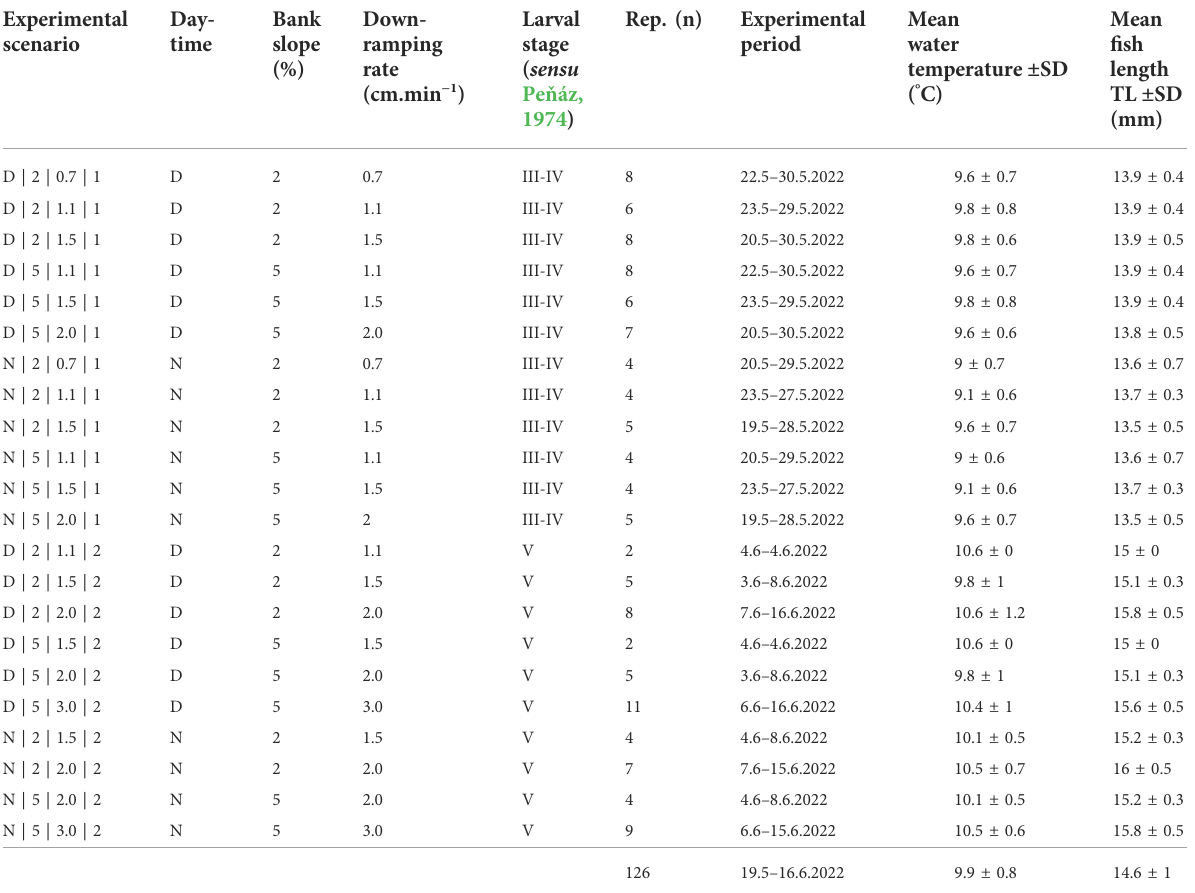
TABLE 1 Overview of the experimental scenarios with the number of independent replicates (n) used for statistical analysis dependent on tested parameters: daytime, bank slope, down-ramping rate, larval stage. Experimental